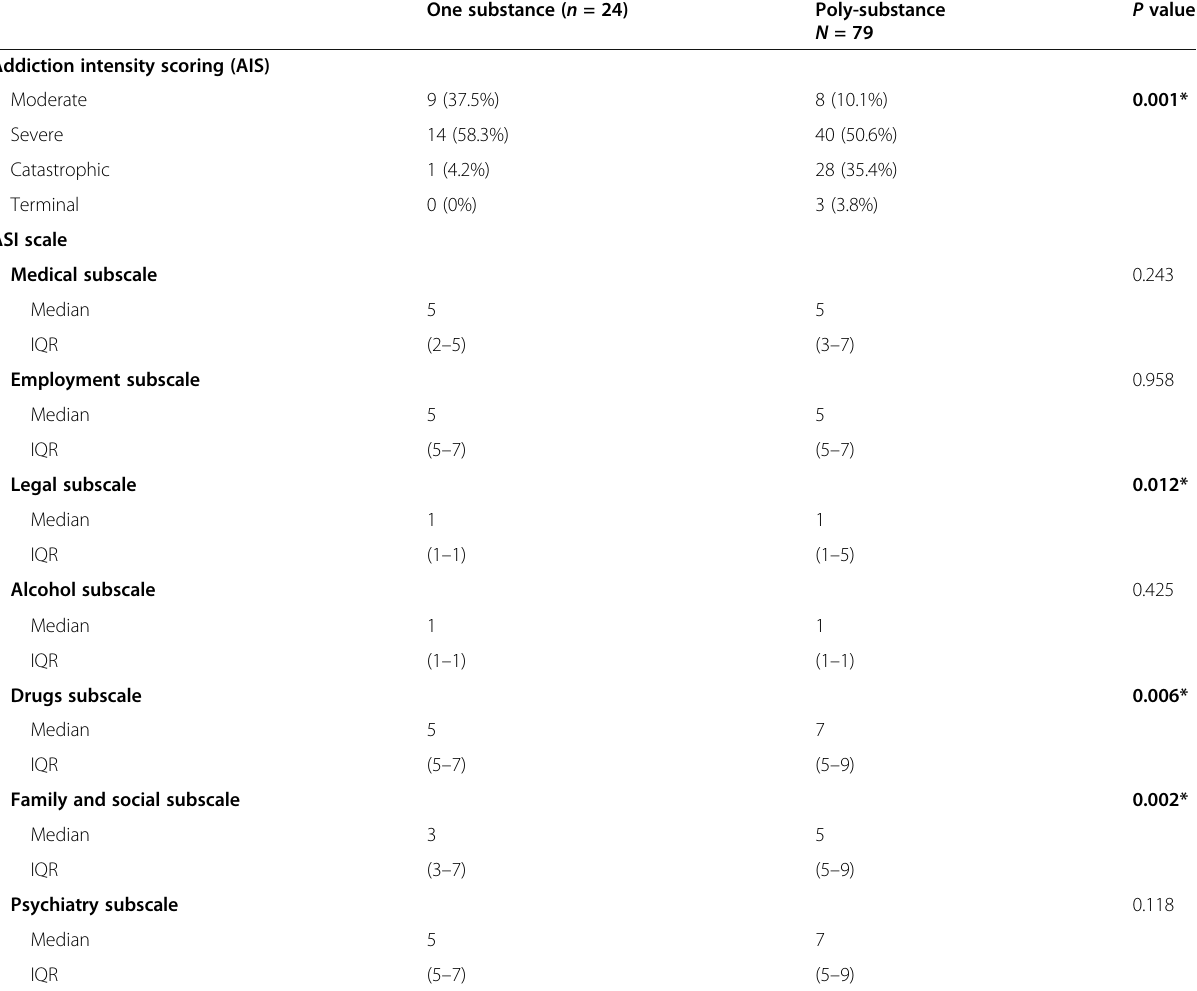
Table 3 Comparison between one-substance and poly-substance groups regarding severity of substance use illness